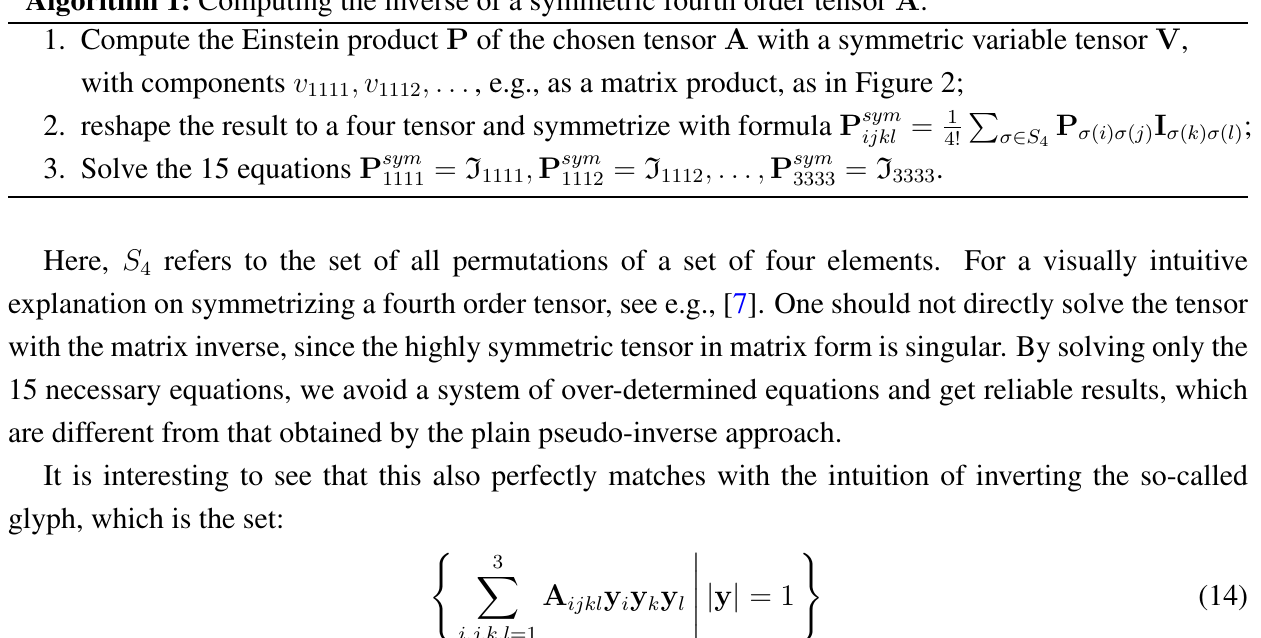
Algorithm 1: Computing the inverse of a symmetric fourth order tensor A .